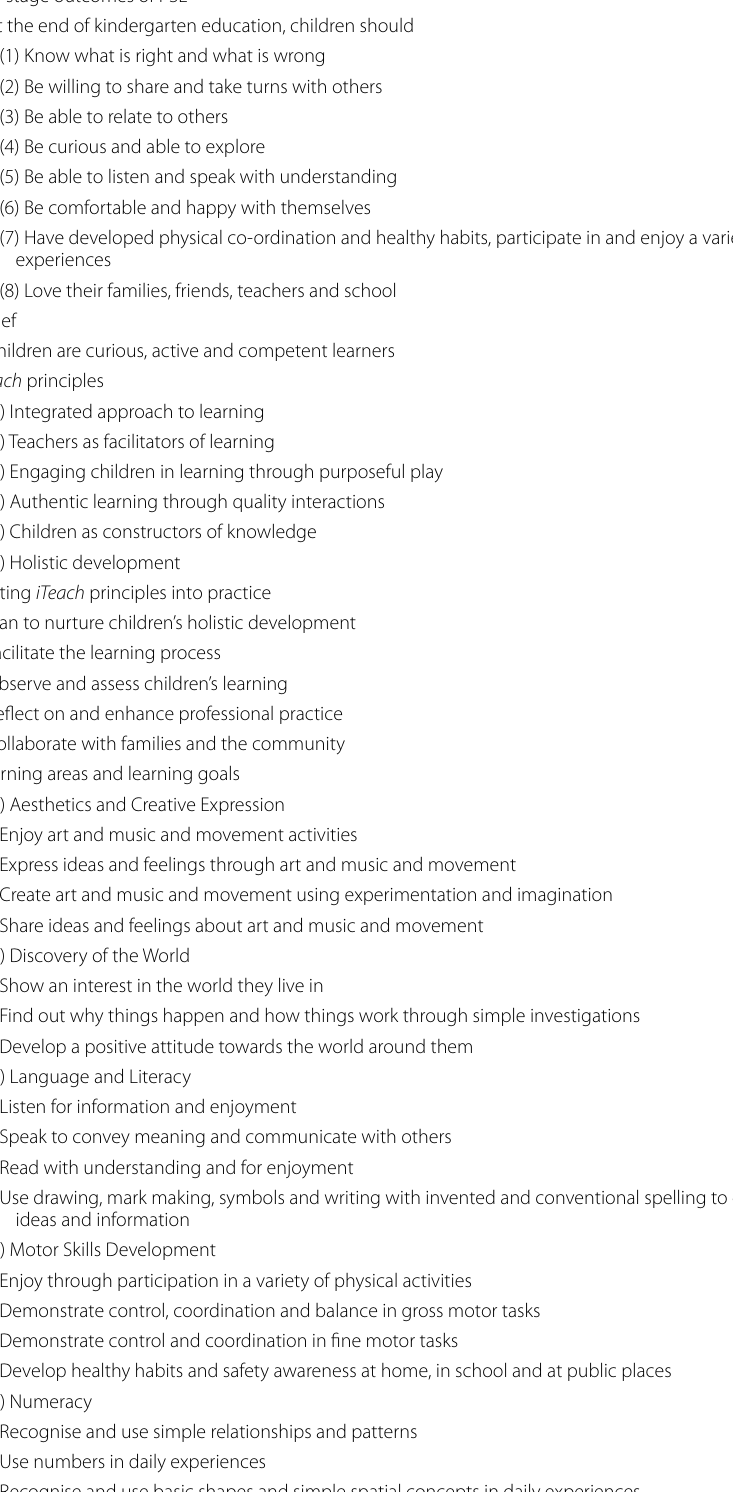
Table 1 Key features of the kindergarten curriculum framework in Singapore (MOE 2012b) Key stage outcomes of